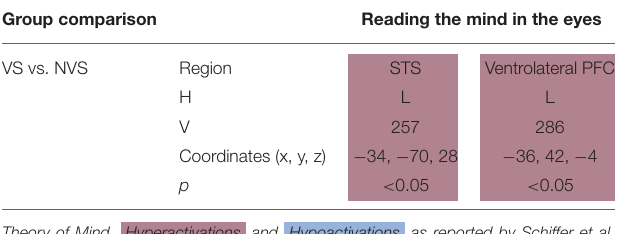
TABLE 6 | Activation patterns in theory of mind task: reading the mind in the eyes test. Group